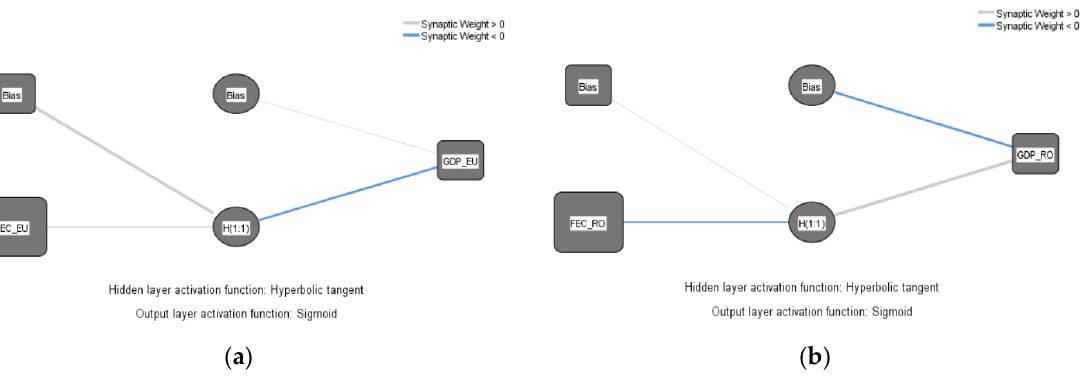
Figure 6. MLP network for identifying the influences of FEC on GDP at the EU and RO levels for 1995–2020: ( a ) EU; ( b )